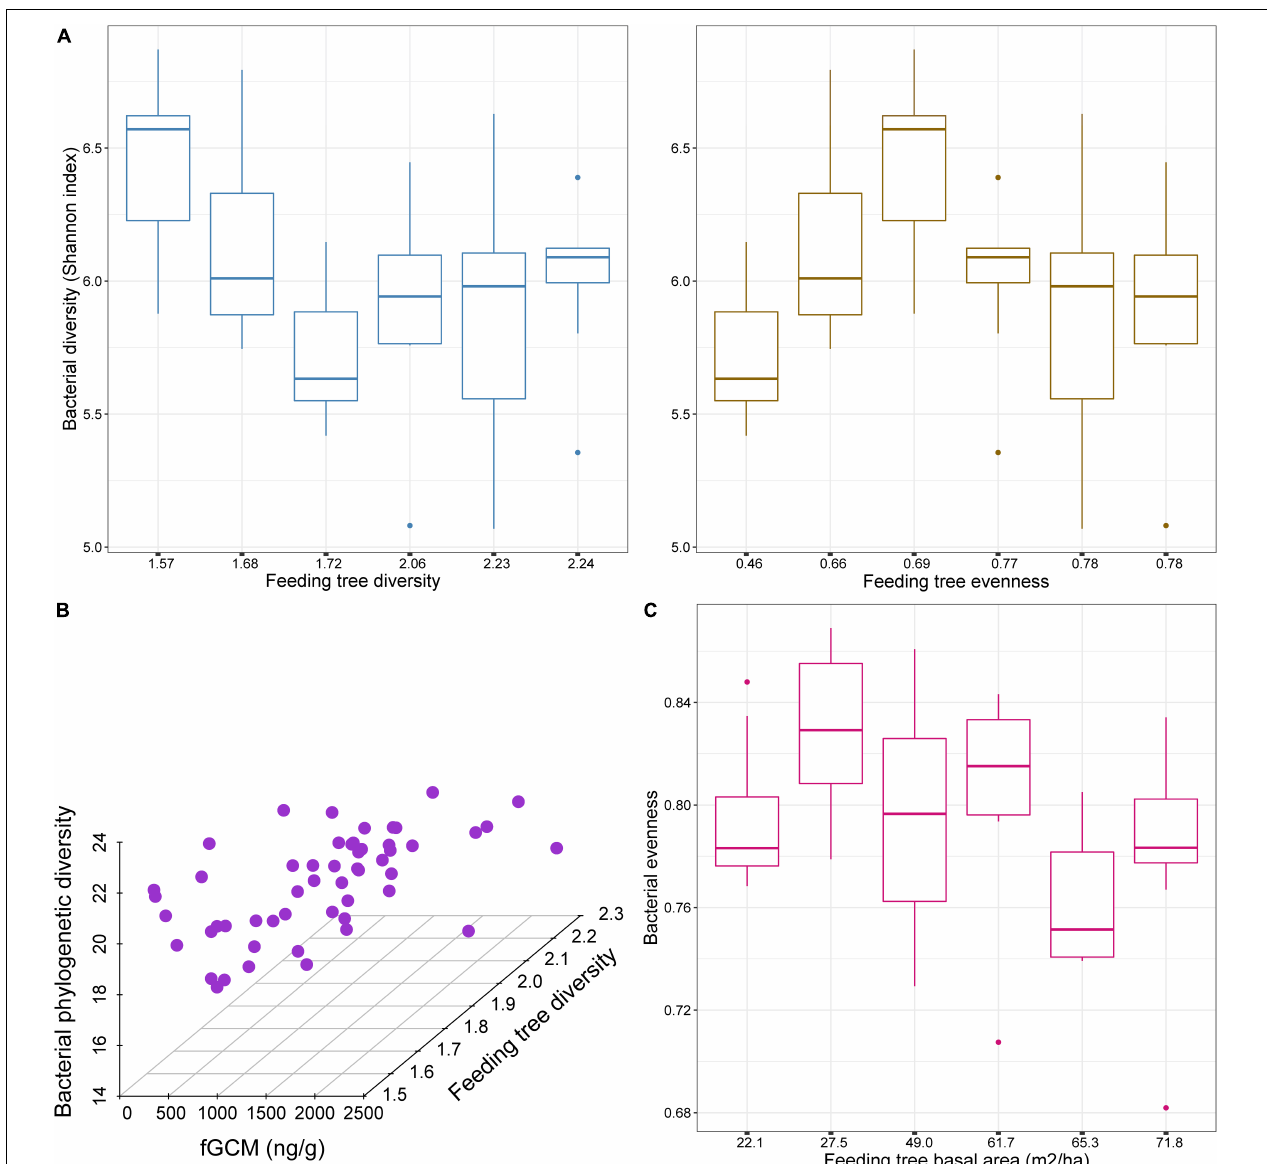
FIGURE 1 | Changes in bacterial alpha diversity associated with variation in food availability indices and physiological stress of black howler monkeys ( Alouatta pigra ) inhabiting disturbed forest fragments at Escárcega, State of Campeche, Mexico. (A) Boxplots show that bacterial diversity is negatively related to feeding tree diversity estimated with the Shannon index, and positively related to feeding tree evenness. (B) Scatterplot shows the effects of an interaction between fecal glucocorticoid metabolites (fGCMs) and diversity of feeding trees estimated with the Shannon index on bacterial phylogenetic diversity. (C) Boxplot shows that bacterial evenness negatively relates to basal area of feeding